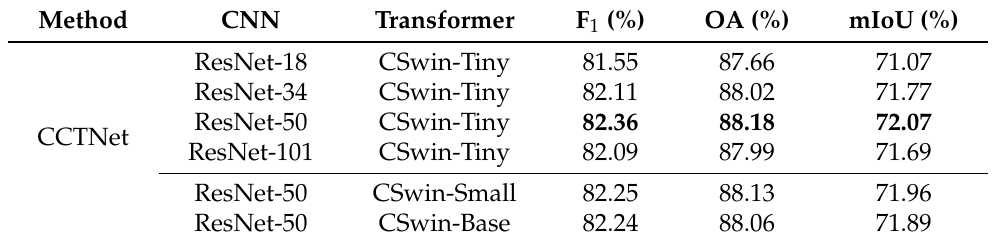
Table 7. Results for the auxiliary loss functions.